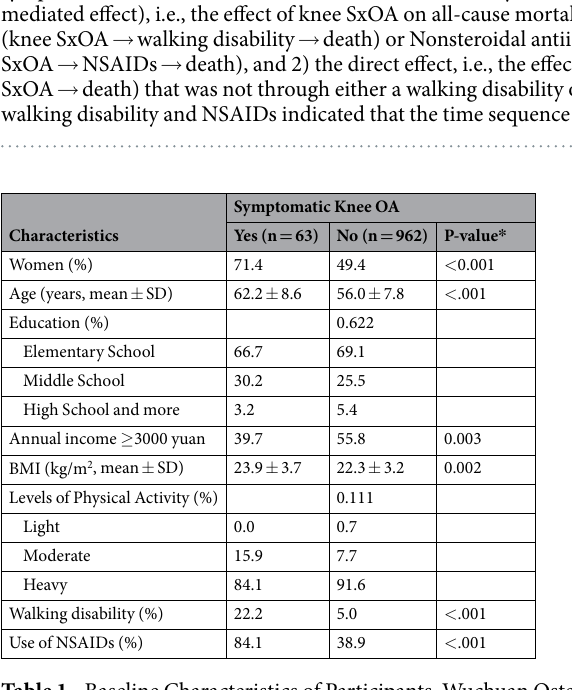
Table 1. Baseline Characteristics of Participants, Wuchuan Osteoarthritis Study, China. * P-values were from t-test for continuous variables and from Chi-square test for categorical